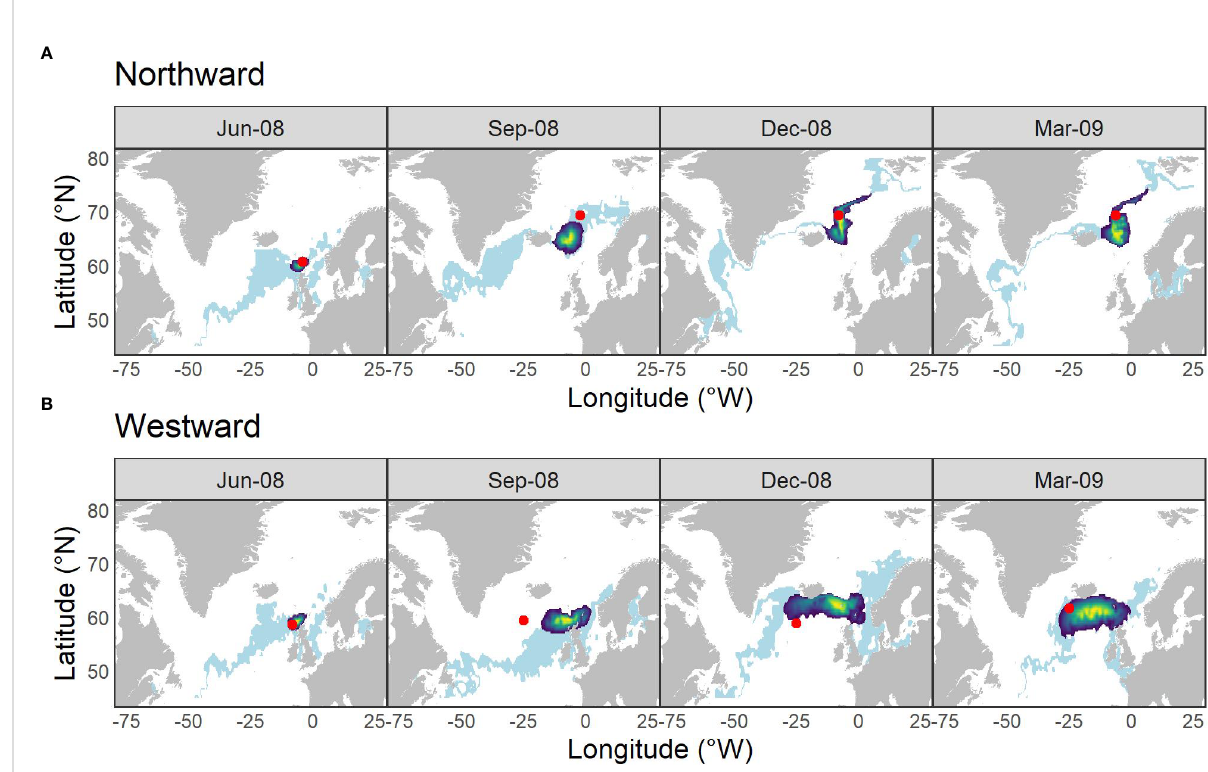
FIGURE 2 Locations inferred from SST at various time points along the (A) northward and (B) westward simulated simpli fi ed migration paths. Light blue banding illustrates the distribution of all locations within s = 1°C of the SST at the true location (red spot); heatmap area indicates 90% C.I. of the density distribution of locations derived from the hidden Markov movement model. Time-steps were restricted to those with T O